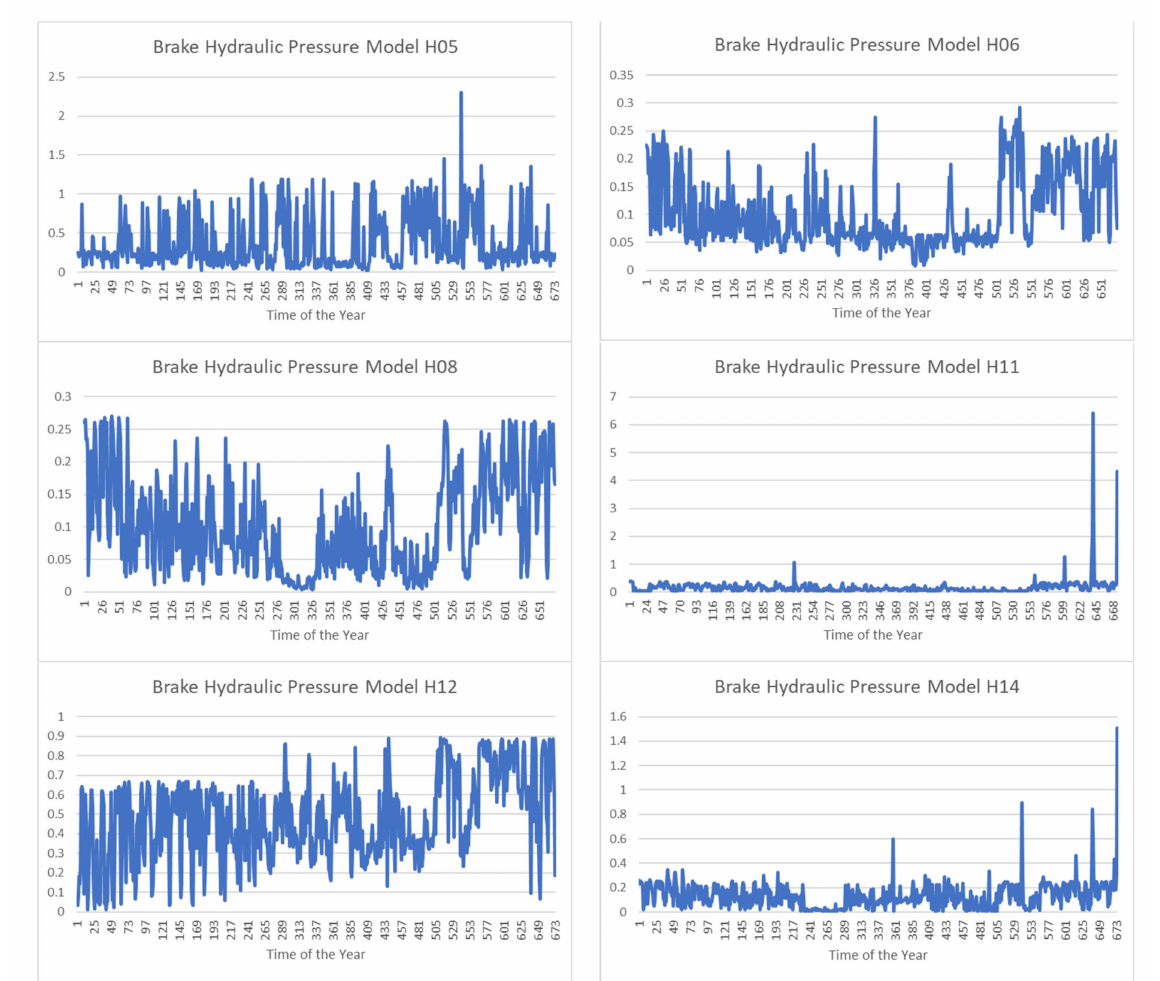
Figure 3. Plotted Mahalanobis distances based on the brake hydraulic pressure model of some wind turbines in the wind